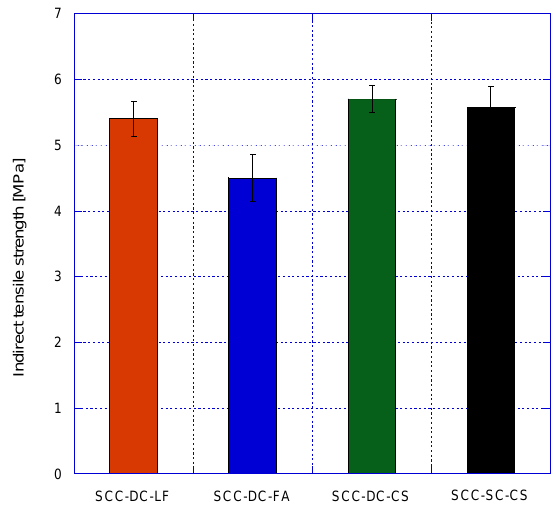
Figure 9. Tensile splitting strength at 90 days for all mixes.